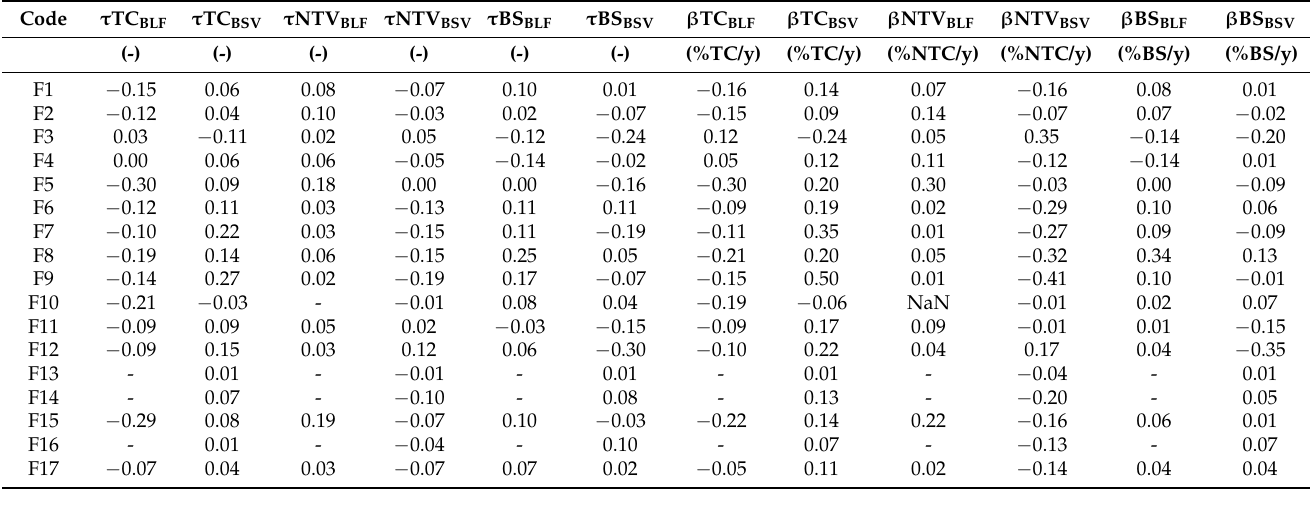
Table 3. The mean Mann-Kendall τ and the Theil-Sen slope β of the tree canopy coverage (TC), non-tree vegetation (NTV), and non-vegetated (bare) coverage (BS) for all the broad-leaved forests (BLFs) and bushy sclerophyllous vegetation (BSV) observed pixels falling within each of the 17 sites analyzed.